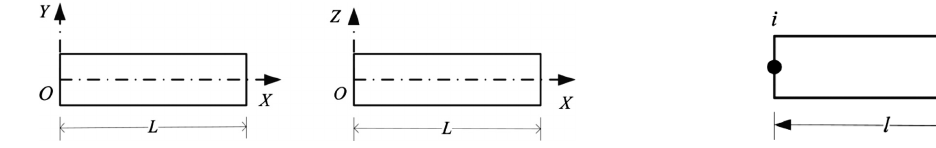
Fig. 1. The coordinate system of beam. Fig. 2. Schematic of a simple Timoshenko beam